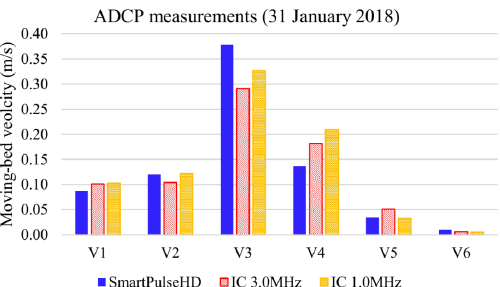
Figure 10. Moving-bed velocities measured with ADCP on 31 January 2018 at the six verticals of cross-section P1, in Taquari River.